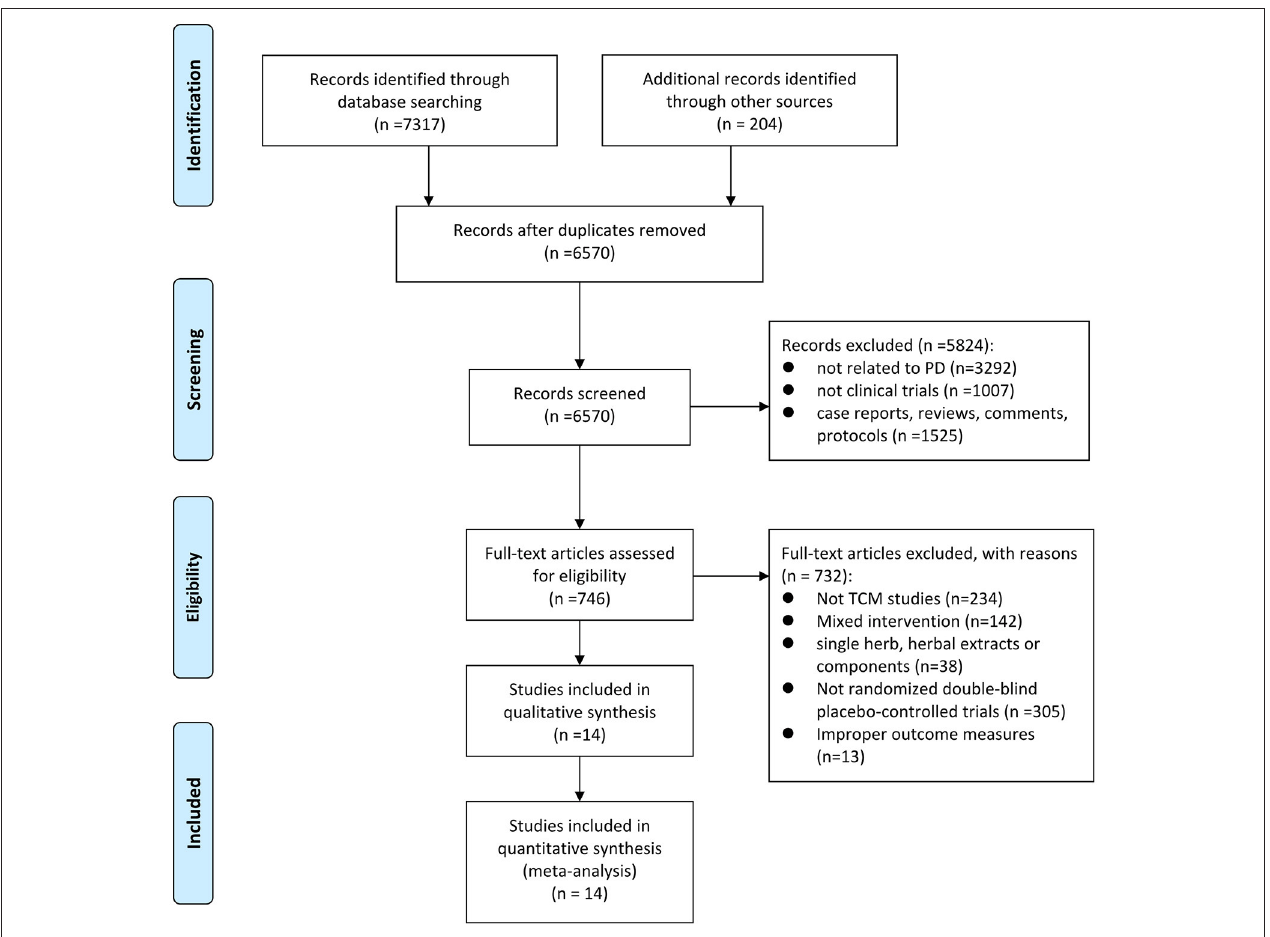
FIGURE 1 | Flow diagram of the search